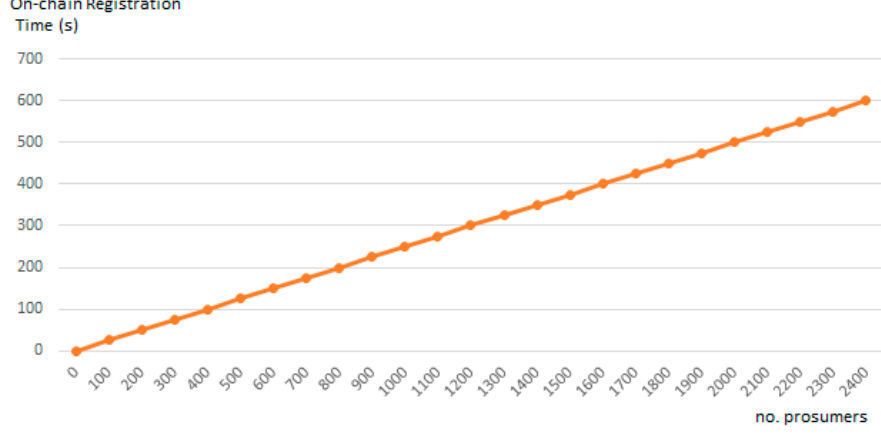
Figure 12. On-chain energy transactions registration time interval and the number of prosumers.